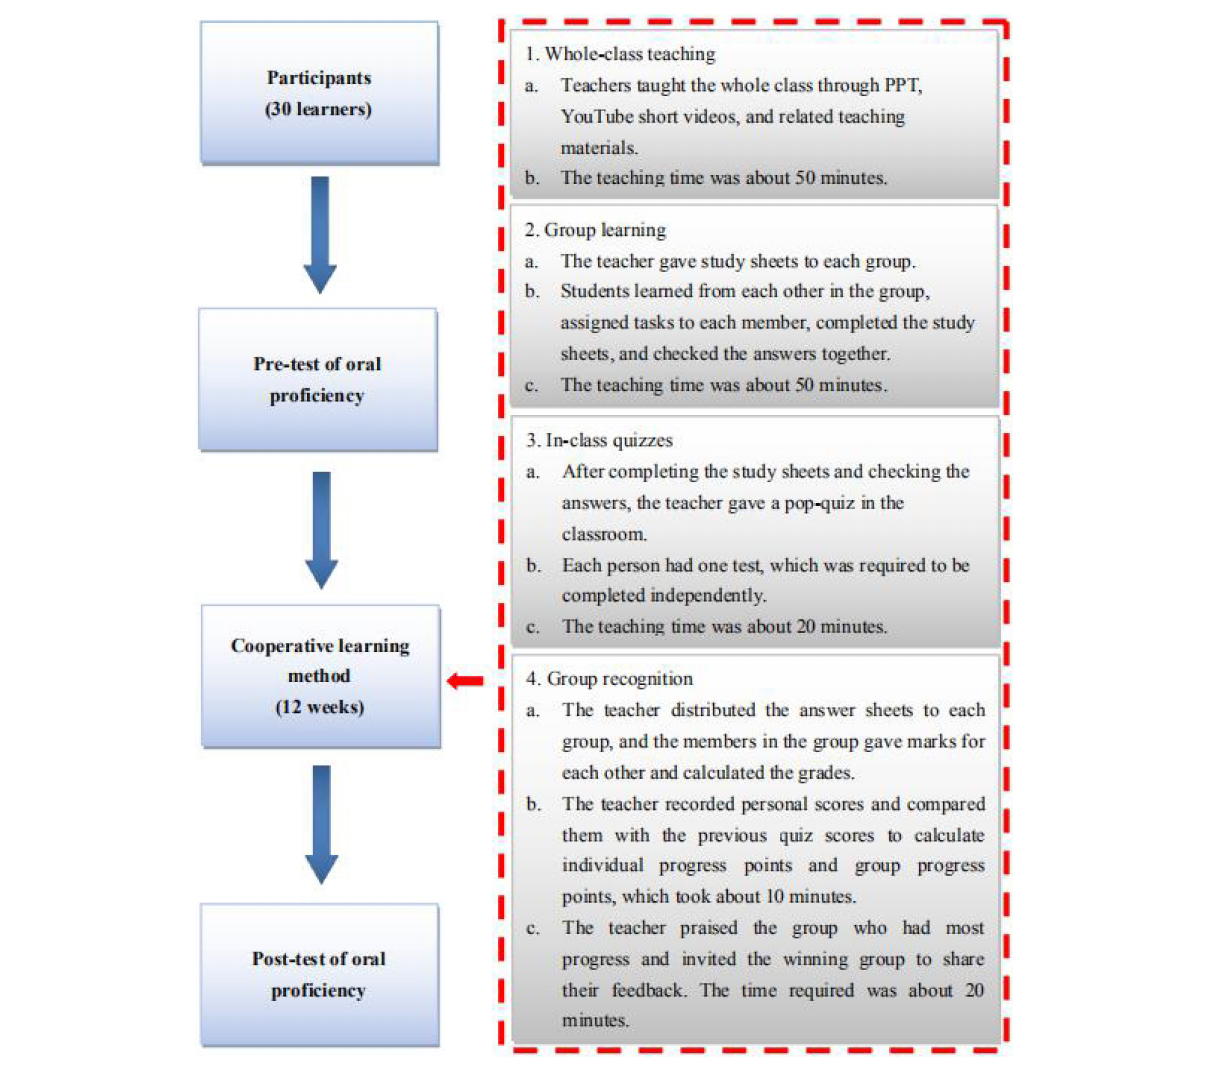
FIGURE 2 | Implementation procedures of the experimental group. TABLE 1 | Basic information of